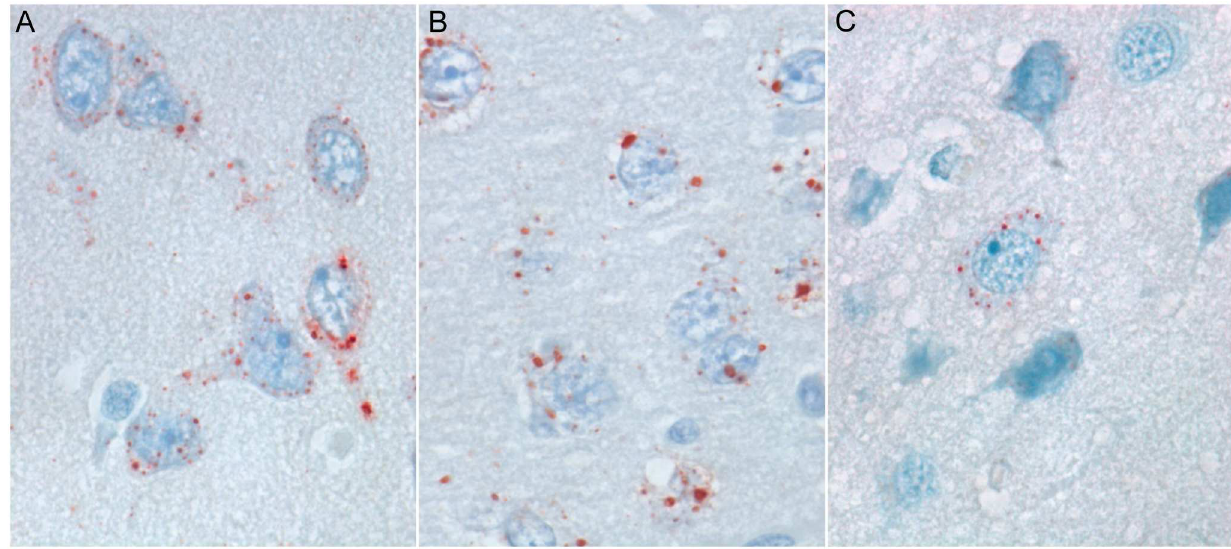
Fig 2. Lyssavirus antigen expression in neurons infected with different strains of Lagos bat virus. All sections immunostained for lyssavirus antigen. Original magnification: x100 ( A , B and C ). A : Senegal strain, relatively large number of neurons are infected, small cytoplasmic antigen (red) granules, infected neurons have variable numbers of granules (Bat 6). B : Nigeria strain, relatively large number of neurons are infected, large cytoplasmic antigen (red) granules, infected neurons have similar numbers of granules (Bat 9). C : Ghana strain, relatively few neurons infected, small cytoplasmic antigen (red) granules (Bat 12).